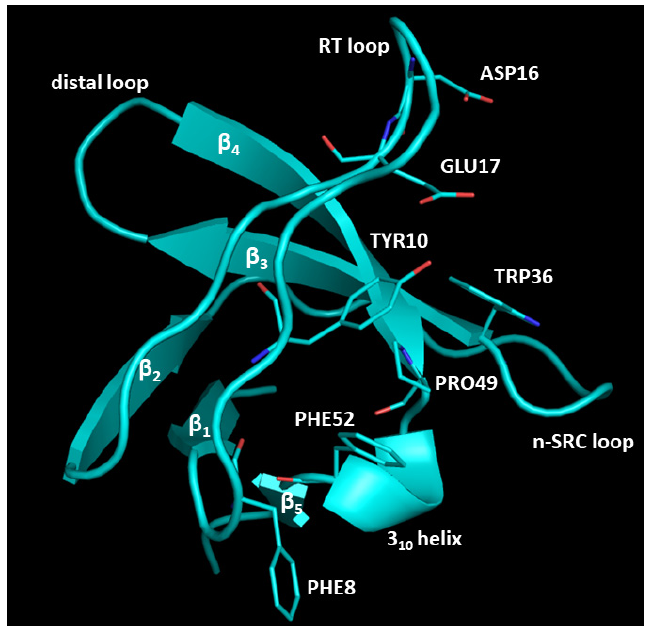
Figure 1. SH3A domain structure of CIN85. The residues of the hydrophobic and acidic pockets are highlighted as cyan sticks. The image was created by PyMOL software v2.4.0